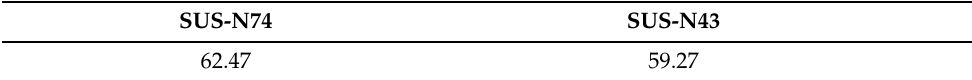
Table 9. The results of system usability scale